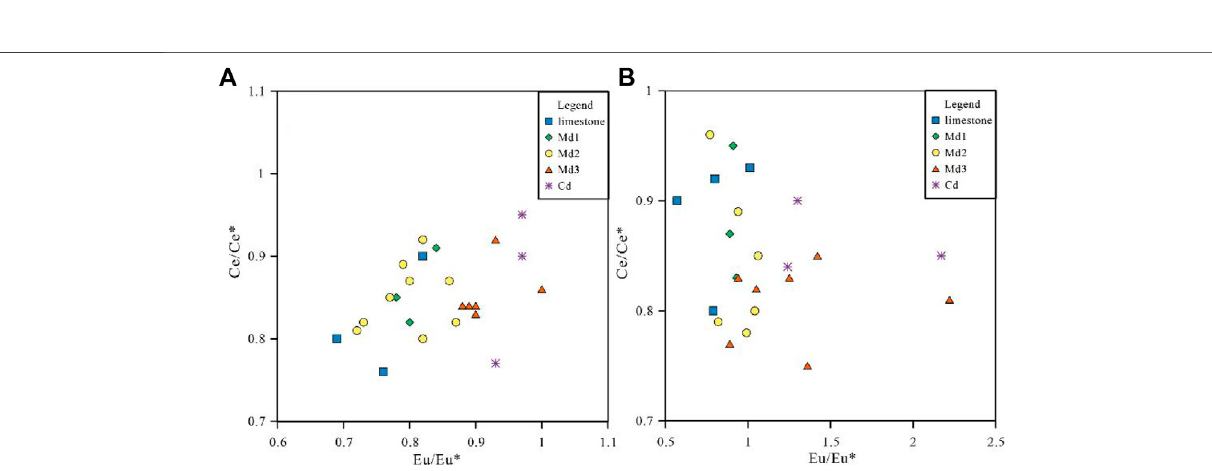
Frontiers in Earth Science |